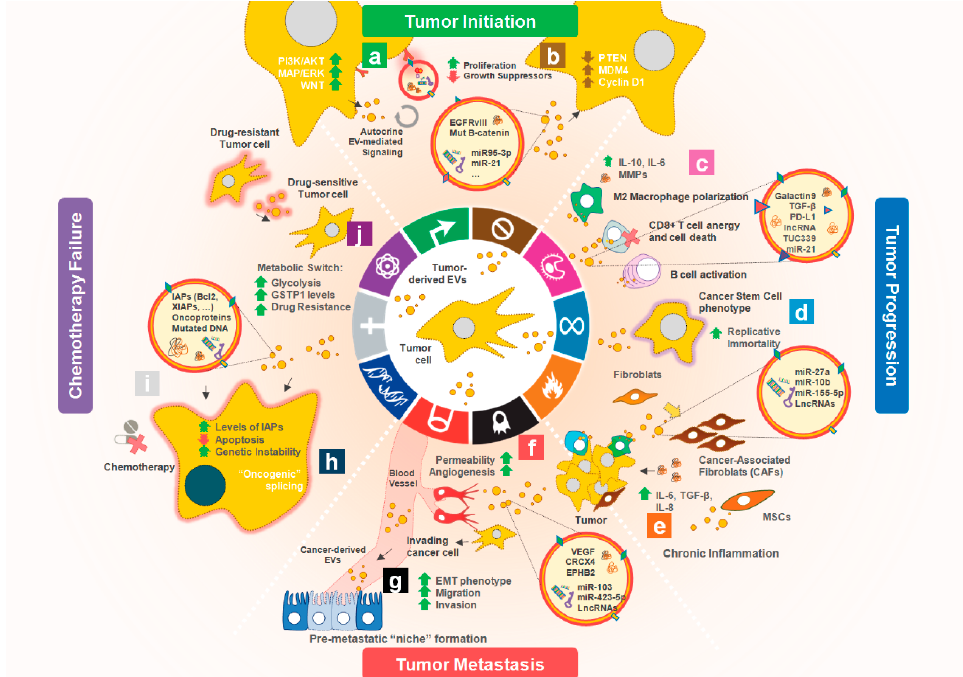
Figure 2. Impact of tumor-derived EVs on the acquisition and maintenance of cancer hallmarks traits. From the onset of tumor initiation, cancer-derived EVs modulate the phenotype of multiple recipient cell types to support tumor progression, metastasis and resistance to therapy. Indeed, many of the cancer cell clones may rely on the shedding of cancer-derived EVs to enable the ( a ) activation of several tyrosine kinase receptors and their downstream signalling pathways (e.g. MAP/ERK, PI3K/AKT and/or WNT). This cancer EV-mediated sustained proliferative signalling can be either autocrine or paracrine and confers tumor cells a key proliferative advantage. Moreover, in a synergistic event, ( b ) cancer-derived EVs also carry many oncoproteins and oncomiRs that when internalized by target recipient cancer cells enable them to override the growth suppressor signalling (e.g. through the reduction of PTEN and exacerbated expression ofMDM4 and/or cyclin D1 “oncogenic” splicing variants). Importantly, for successful tumor progression, tumor cells must acquire the ability to ( c ) evade immune destruction. Cancer-derived EVs serve this purpose as vectors for many immunosuppressive molecules, including galactin9 which binds TIM-3 on T cells inducing their death. Additionally, EV-associated TGF- β , PD-L1 and several miRs induce an immunosuppressive phenotype when internalized by immune cells. This includes the induction of a M2-like secretion profile on macrophages, CD8+ T cells anergy or stimulation of B and T cells to secrete a wide array of tumor supporting cytokines. ( d ) Cancer-derived EVs cargo may include TERT mRNA and/or other non-coding RNAs that induce the expression of telomerase in recipient fibroblasts and in other mutated cell clones, enabling a cancer stem cell phenotype with the acquisition of replicative immortality.( e ) Cancer-derived EVs are also an important player for the perpetuation of chronic inflammation within the tumor microenvironment, which fosters multiple hallmark functions. Cancer-derived EVs carry several miRs including miR-27, -10b, -155-5p and other LncRNAs that target nearby fibroblasts, transforming them into cancer-associated fibroblasts (CAFs). In turn, CAFs secrete high amounts of IL-6 and TGF- β to the tumor microenvironment. Many of these cancer-derived EVs can also “educate” nearby Mesenchymal Stromal Cells (MSCs) to secrete large amounts of IL-8 and other immunosuppressive cytokines. Interestingly, this inflammatory microenvironment is prone to promote the formation of new blood vessels towards the tumor. ( f ) In fact, cancer-derived EVs cargo may also include VEGF, CRCX4 and EPHB2 and other epigenetic modulators, such as miR-103 as well as other lncRNAs, that increase the permeability of nearby blood vessels recruiting endothelial tip cells to promote angiogenesis. ( g ) Many of these EVs carry Matrix Metalloproteases (MMPs) and upon internalization by nearby cancer cells activate an Epithelial to